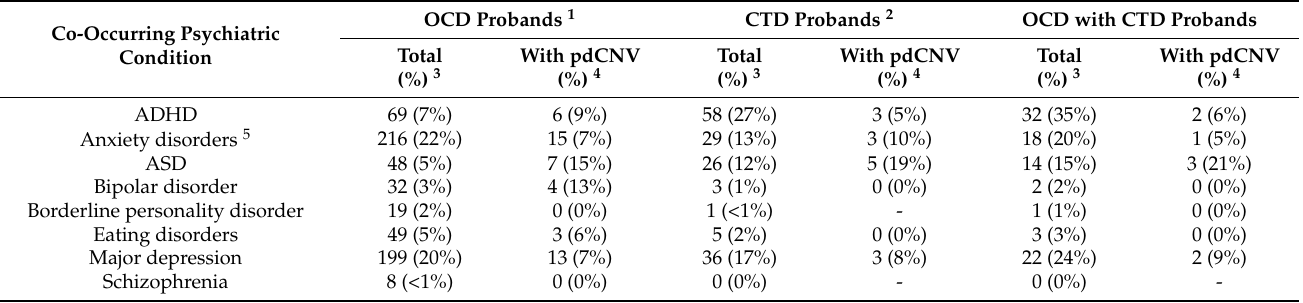
Table 4. Co-occurring psychiatric conditions in all probands and probands with potentially damag- ing CNV.